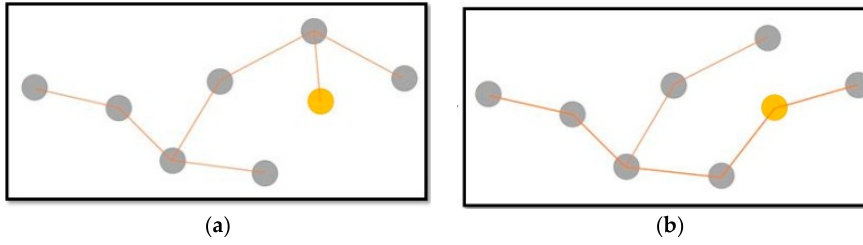
Figure 8. In gray the current tree vertices, in yellow the new vertex. ( a ) RRT standard resulting path; ( b ) RRT* optimal resulting path.